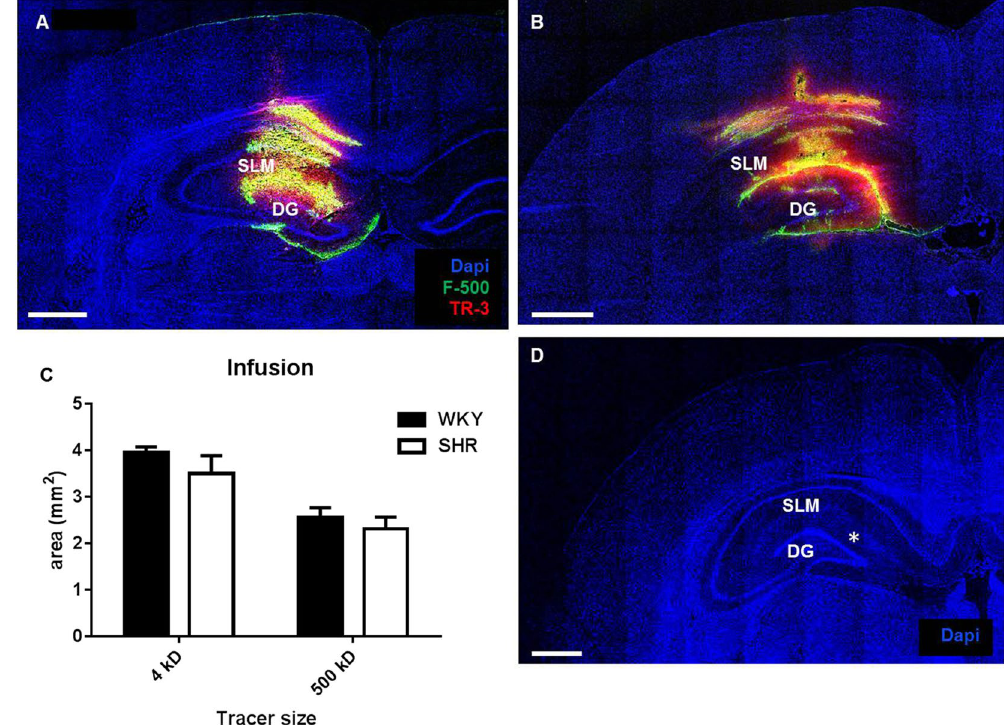
Figure 1. Distribution of fluorescent tracers after infusion into the hippocampus. Panel A and B show coronal slices of WKY (left) and SHR (right) hippocampus at the infusion level. We did not observe a difference in the distribution area of either the low or high molecular weight tracer between WKY (N = 6) and SHR (n = 7). Mean data ± SEM are shown in panel C. In panel D the expected infusion site ( * ) is shown, based on the stereotactic coordinates for the rat brain. Scale bar 1